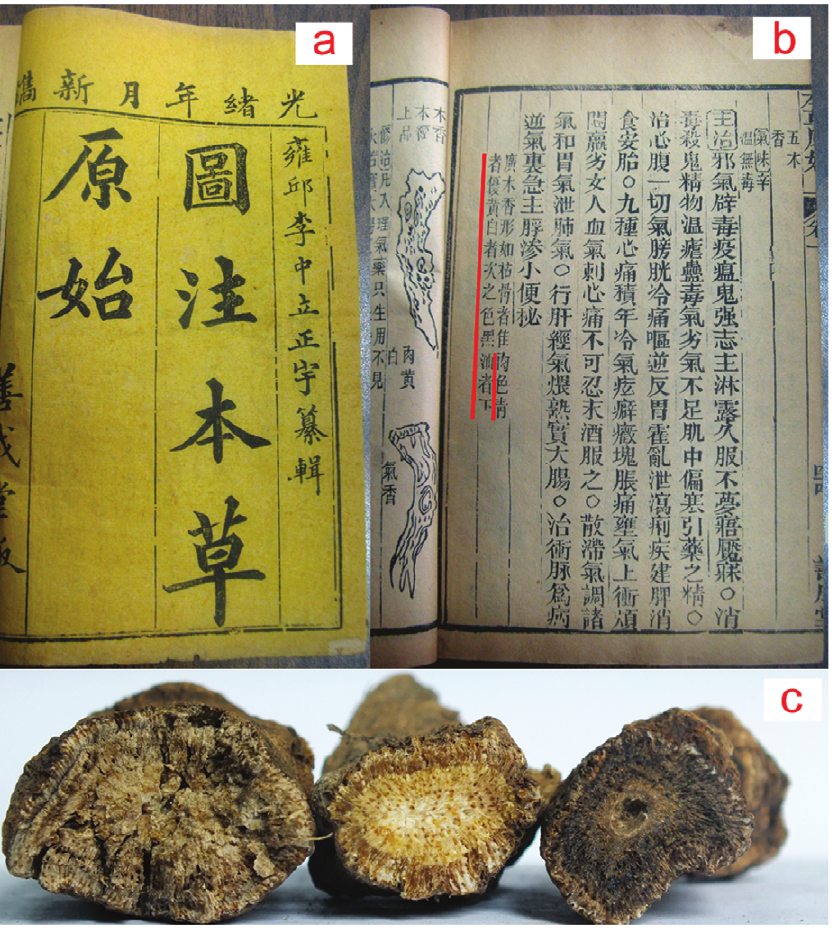
Figure 1. The herbal classic OriginoftheMateriaMedica ( BenCaoYuanShi ) describes the color-based quality evaluation of Chinese herbal materials. a) Origin of the Materia Medica , written by Zhong-li Li in 1612 during the Ming Dynasty, has been considered the first of the herbal classics in China, which described the sensory characteristics for identification of commercial herbal materials (the medicinal parts of the plants) in detail rather than the plant morphology. b) The original description in the book for the color-based quality evaluation of Aucklandia root ( Aucklandia lappa Decne, muxiang in Chinese). Aucklandia root is an herb that has been commonly used to treat gastroenterological diseases in China for over two thousand years. c) Photographs of the Aucklandia root samples in different color. The quality of Aucklandia root can be placed into three grades based on the color of its fracture surfaces: cadet blue denotes superior quality (left); yellowish-white indicates ordinary quality (middle); and an oleaginous black color suggests inferior quality (right).